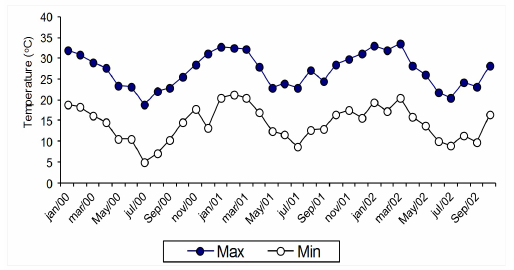
Figure 3. Monthly maximum and minimum temperatures